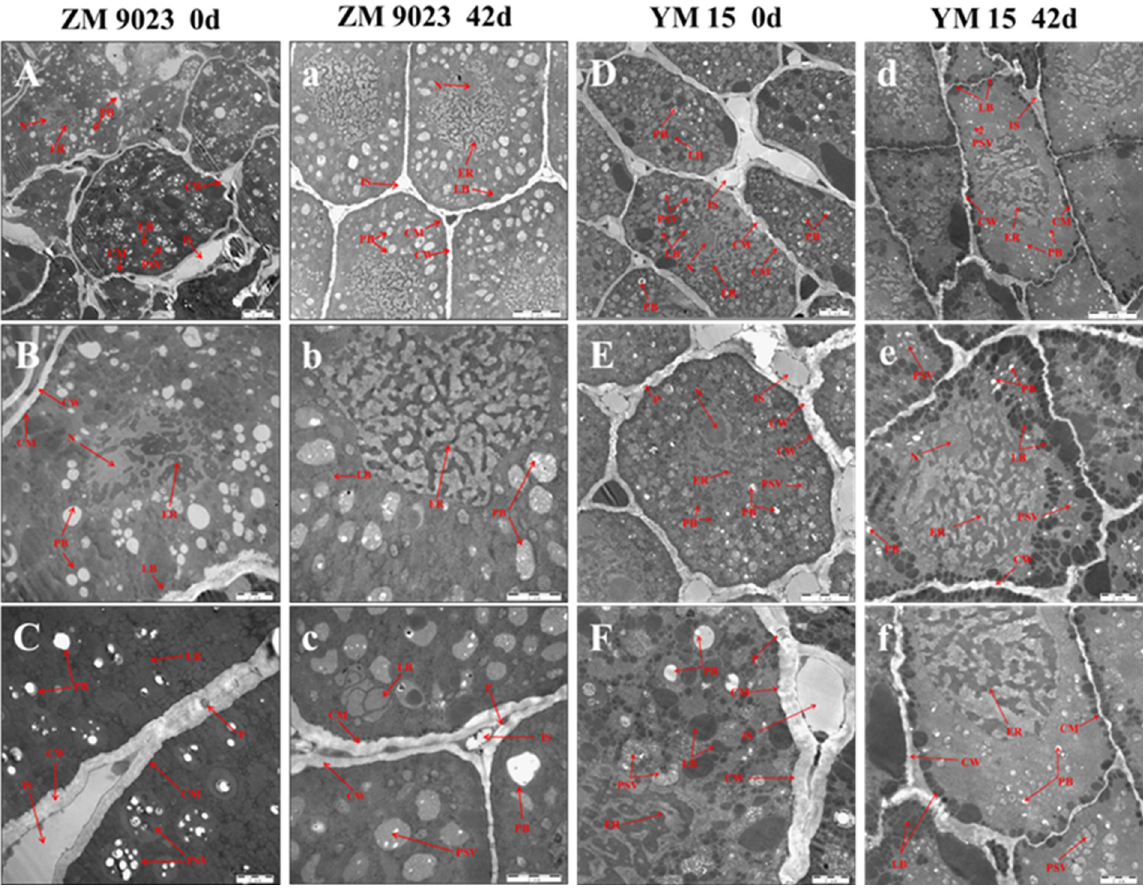
Fig 7. Changes in the ultrastructures of wheat embryo cells of the cultivars ZM 9023 and YM 15 during artificial aging. A–C: ZM 9023 artificial ageing treatment at 0 d; a–c: ZM 9023 artificial ageing treatment at 42 d; D–F: YM 15 artificial ageing treatment at 0 d; d–f: YM 15 artificial ageing treatment at 42 d. CM: Cell membrane; CW: Cell wall; ER: Endoplasmic reticulum; IS: Intercellular space; LB: Lipid body; N: Nucleus; P: Plasmodesmata; PB: Protein body; PSV: Protein storage vacuole.